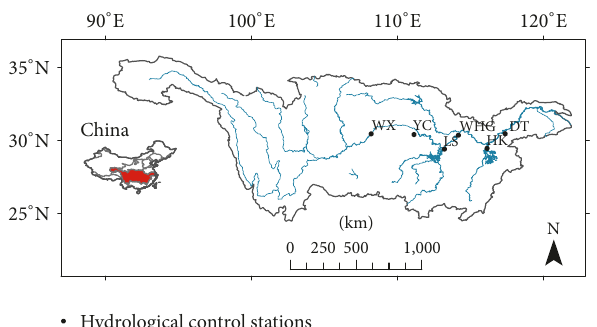
Figure 1: Study area, Yangtze River Basin, and the locations of the selected discharge